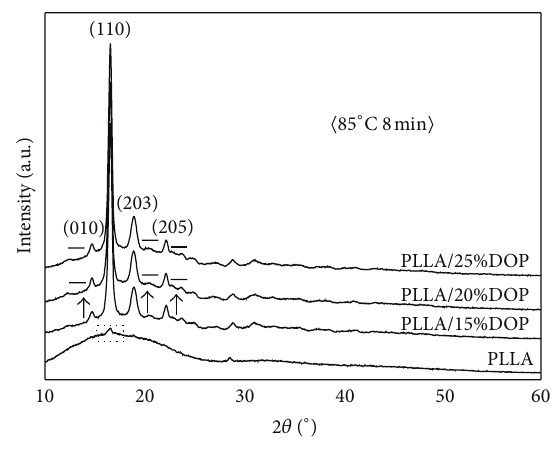
Figure 4: XRD curves of PLLA and PLLA/DOP samples for 8min at 85 ∘